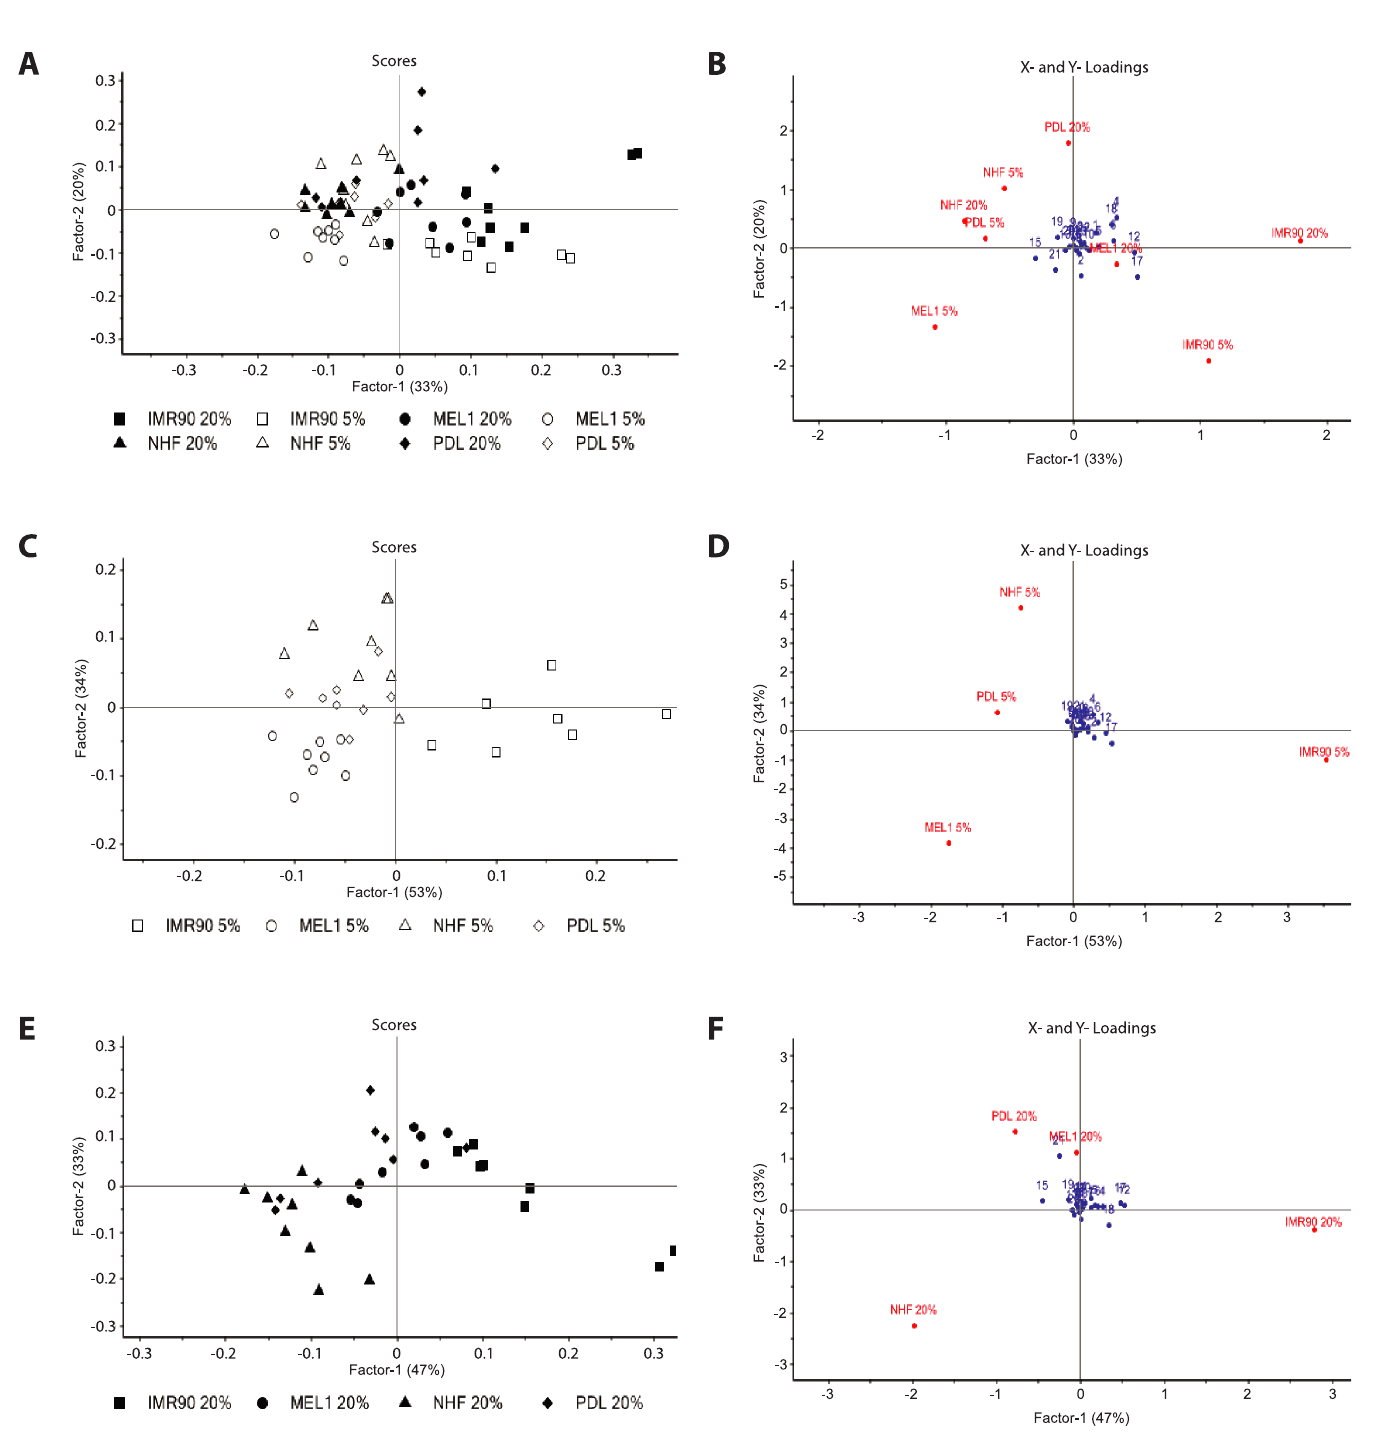
Fig 1. Partial Least Squares Discriminant Analysis (PLSDA) of metabolite concentrations present in spent medium from IMR90, PDL and NHF1.3 human iPS cells and MEL1 human ES cells. ( A, C, E ) PLSDA scores plots of medium samples from human ES and iPS cells cultured in 5% and 20% oxygen (A), 5% only (C) and 20% only (E). Each data point represents the entire metabolite profile for each sample. Samples closer together have similar metabolite profiles; samples diagonally opposed are more dissimilar. ( B, D, F ) PLSDA loadings plots of metabolite use by human ES and iPS cells cultured in 5% and 20% oxygen (B), 5% only (D) and 20% only (F). n = 8 samples per line per treatment, from 4 independent biological replicates. Numbers refer to metabolites: (1) alanine, (2) arginine, (3) aspartate, (4) cystine, (5) GABA, (6) glucose, (7) glutamate, (8) glutamine, (9) glycine, (10) histidine, (11) isoleucine, (12) lactate, (13) leucine, (14) lysine, (15) methionine, (16) phenylalanine, (17) proline, (18) pyruvate, (19) serine, (20) threonine, (21) tryptophan, (22) tyrosine, (23) valine.